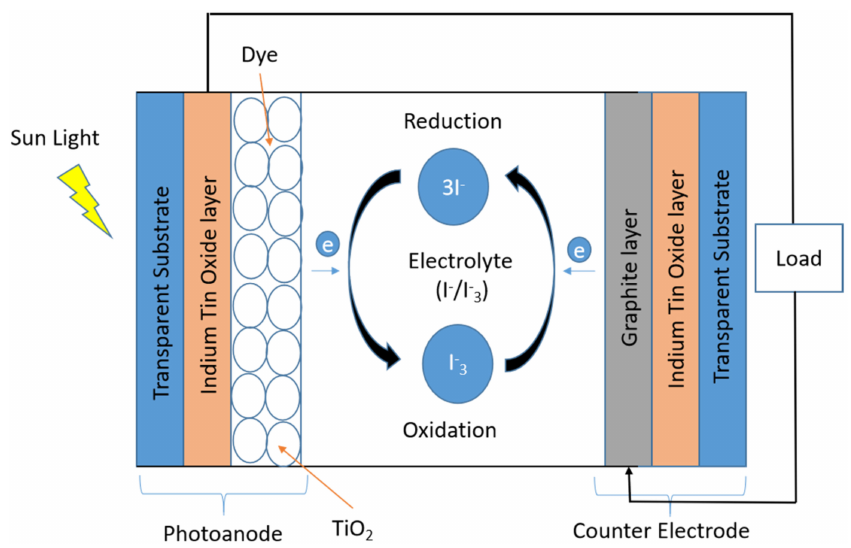
Figure 1. A dye-sensitized solar cell schematic diagram